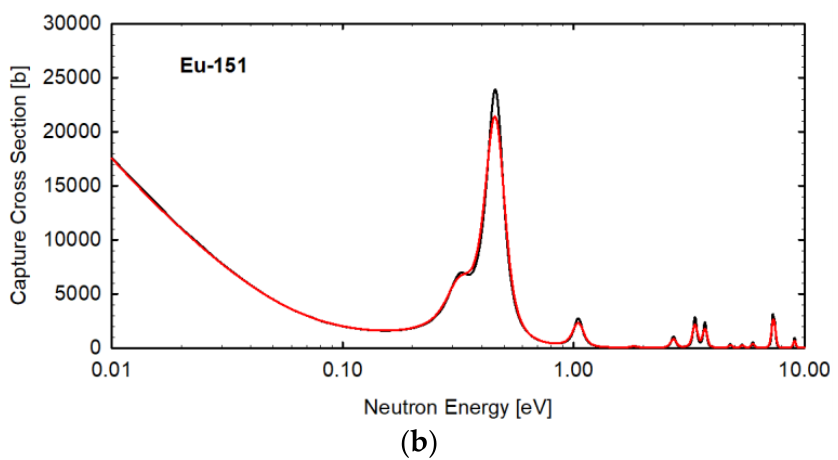
Figure 2. ( a ) Capture cross section of 241 Am for sample temperatures 𝑇 𝑠 = 300 K (black solid line) and 𝑇 𝑠 = 1000 K (red solid line) calculated with a free-gas model and JENDL-4.0 data at 𝑇 𝑠 = 0 K; ( b ) the same with (a) for 151 Eu.